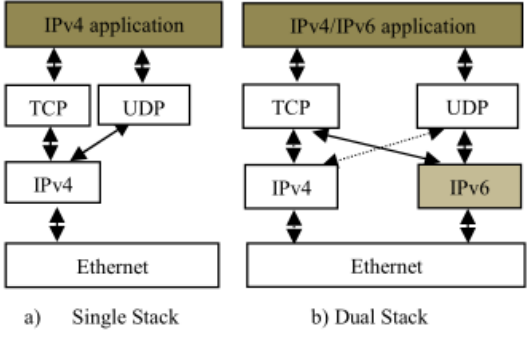
Fig. 1. Single and dual stack IP version architecture at OSI network layer